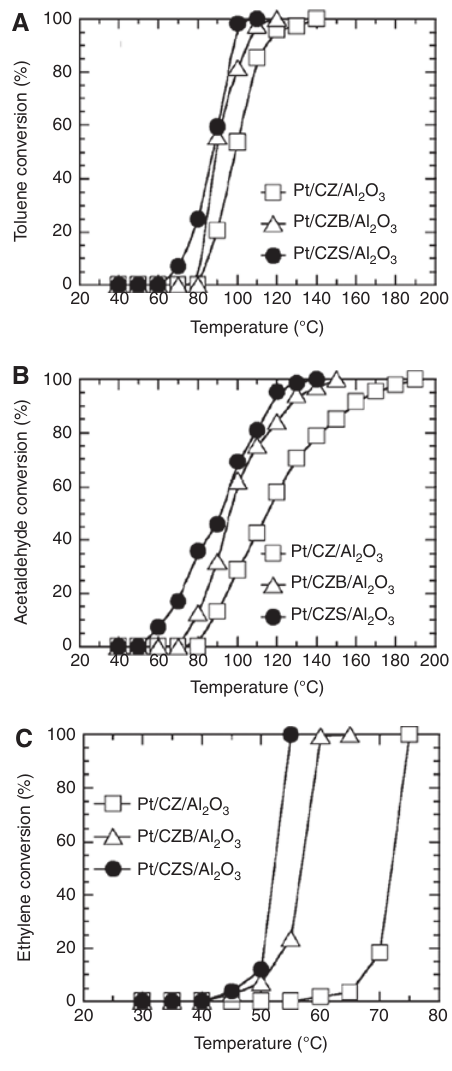
Figure 13: Temperature dependences of (A) toluene, (B) acetaldehyde and (C) ethylene oxidation over the Pt/CZ/Al Pt/CZB/Al O and Pt/CZS/Al 2 3 Ce Zr Bi O ; CZS, Ce 0.64 0.16 0.20 1.9 with permission from the Chemical Society of Japan.